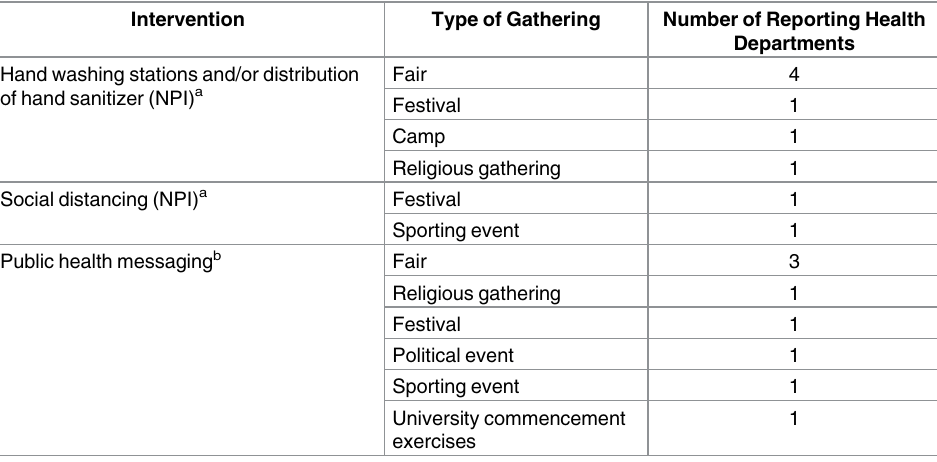
Table 4. Number of state and local health departments reporting implementing nonpharmaceutical interventions (NPIs) and public health messaging at mass gatherings by type of gathering, United States, 2009–2014. Reportedby state and local health departments through an onlineassessment, March— April